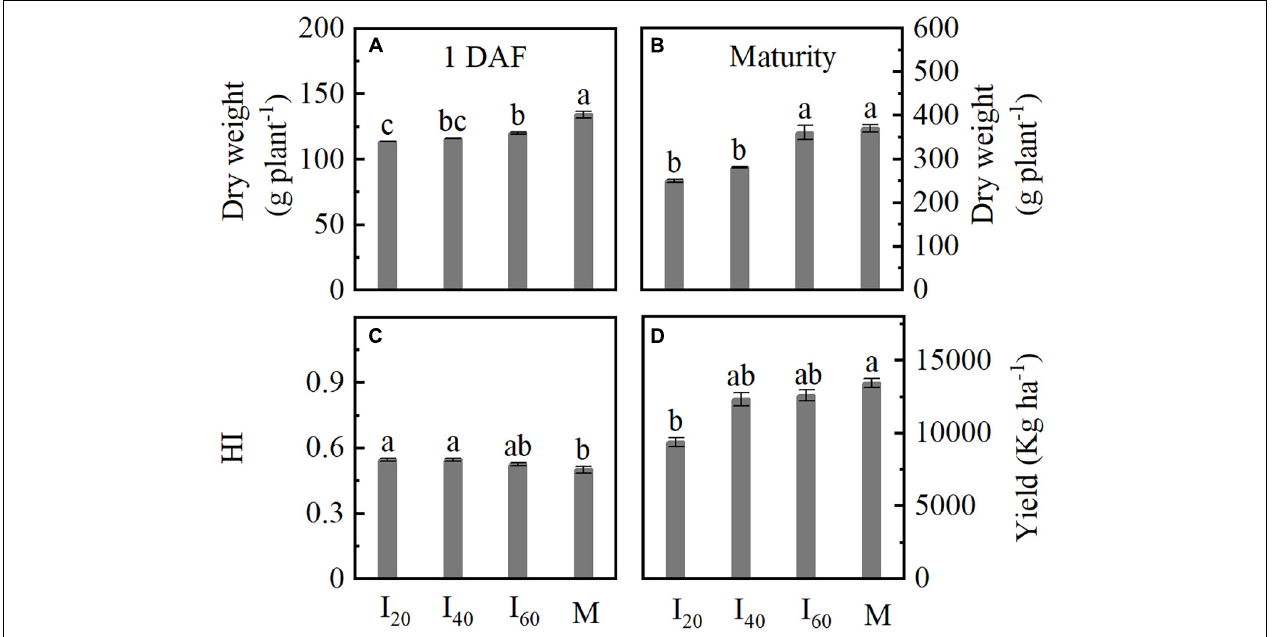
FIGURE 5 | Dry weight, harvest index (HI), and kernel yield of maize in Study 1 (2020). I 20 , I 40 , and I 60 represent the intercropping maize planted in the narrow–wide row spacing patterns, narrow and wide row spacing of 20 + 200, 40 + 180, and 60 + 160 cm, respectively. M: monoculture maize with a row spacing of 70 cm.